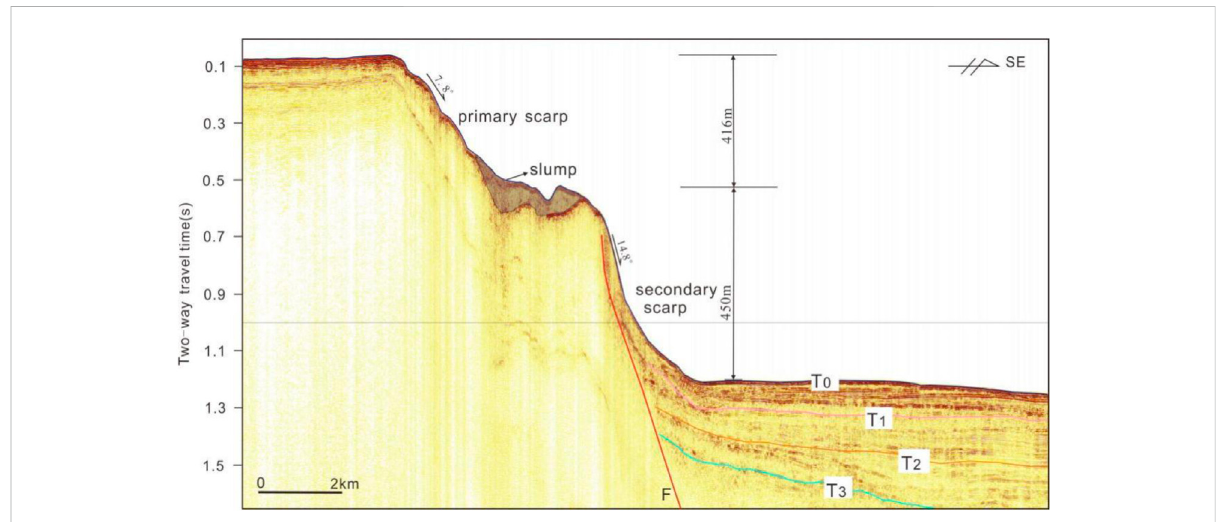
FIGURE 4 The re fl ection characteristics of stepped scarps and slumping deposits are shown on a single